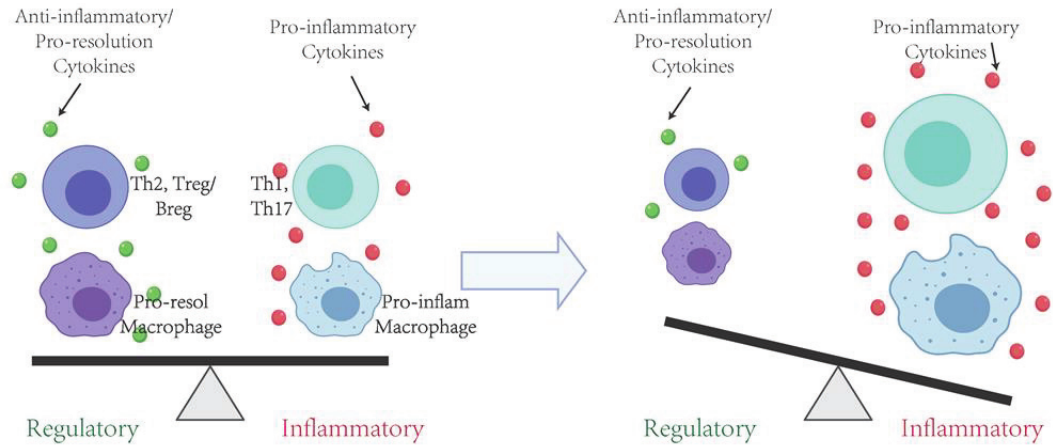
Figure 1. Immune responses directly contribute to the pathogenesis of periodontitis. A balanced pro- and anti-inflammatory responses need to be achieved to maintain tissue homeostasis. If the pro-inflammatory subtype of cells is predominantly persisted, it is inclined towards tissue destruction and bone resorption. Conversely, if the anti-inflammatory and pro-resolving lineages are predominantly developed in a timely fashion, inflammation will be controlled, and tissues will be repaired or regenerated.